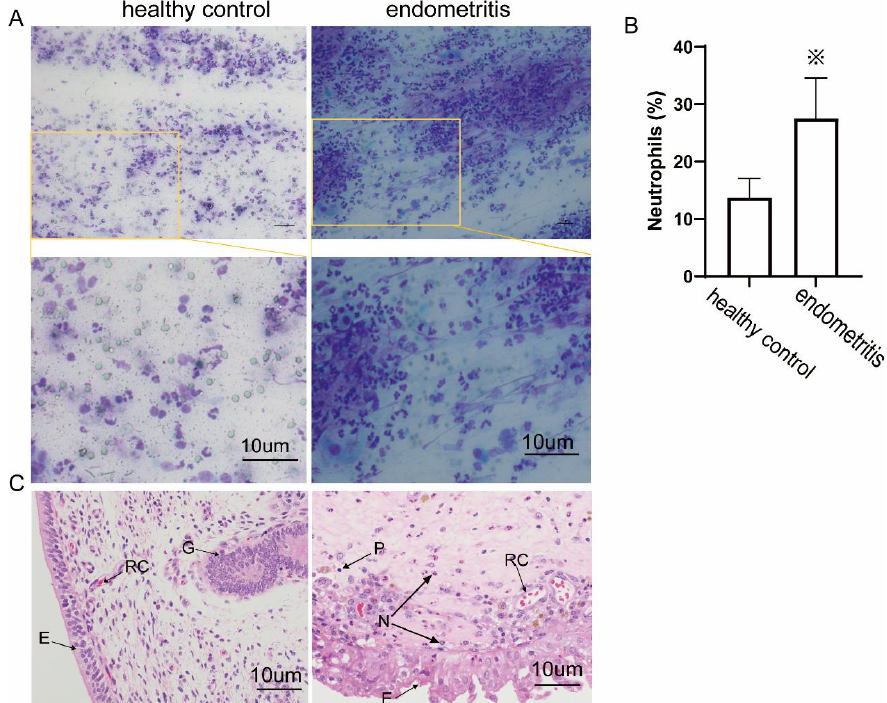
Figure 1. Endometritis-induced neutrophil recruitment in vaginal discharge and endometrial tissue. ( A ) Diff-Quick staining images of neutrophils in vaginal discharge; lobulated nucleus-shaped cells are neutrophils; black bar = 10 µm. ( B ) Ratio of neutrophils in vaginal discharge; endometritis group, n = 10; healthy group, n = 4. ※ p < 0.05. ( C ) Histopathological characteristic images of endometrial biopsy specimens from postpartum cows. E, endometrial epithelium; G, uterine glands; N, neutrophils (lobulated nucleus-shaped cells); RC, red cells; P, plasma cells (deeply stained nuclei, wheel-mounted, with less cytoplasm); 400 ×